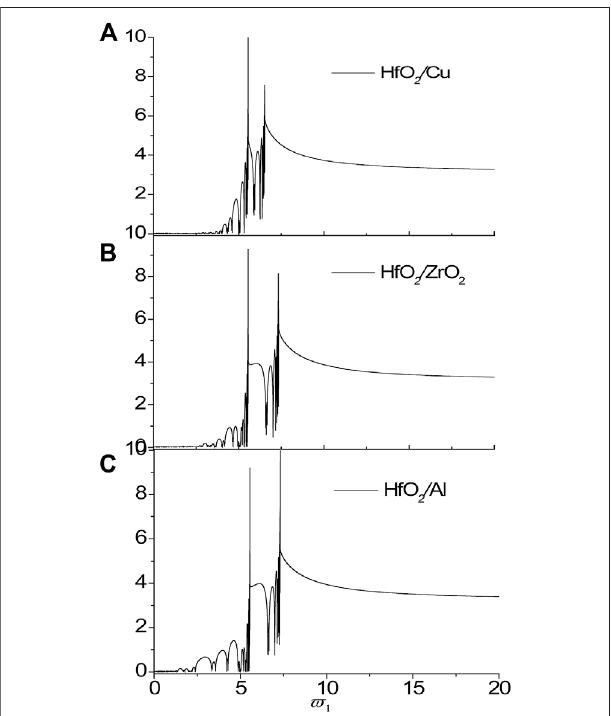
FIGURE5| ThelocalizationfactorsoftheSHwavepropagatingnormally in the nanoscale aperiodic Thue-Morse sequences consisting of HfO 2 /Cu (A) , HfO 2 /ZrO 2 (B) and HfO 2 /Al (C) for τ 1 = τ 2 =